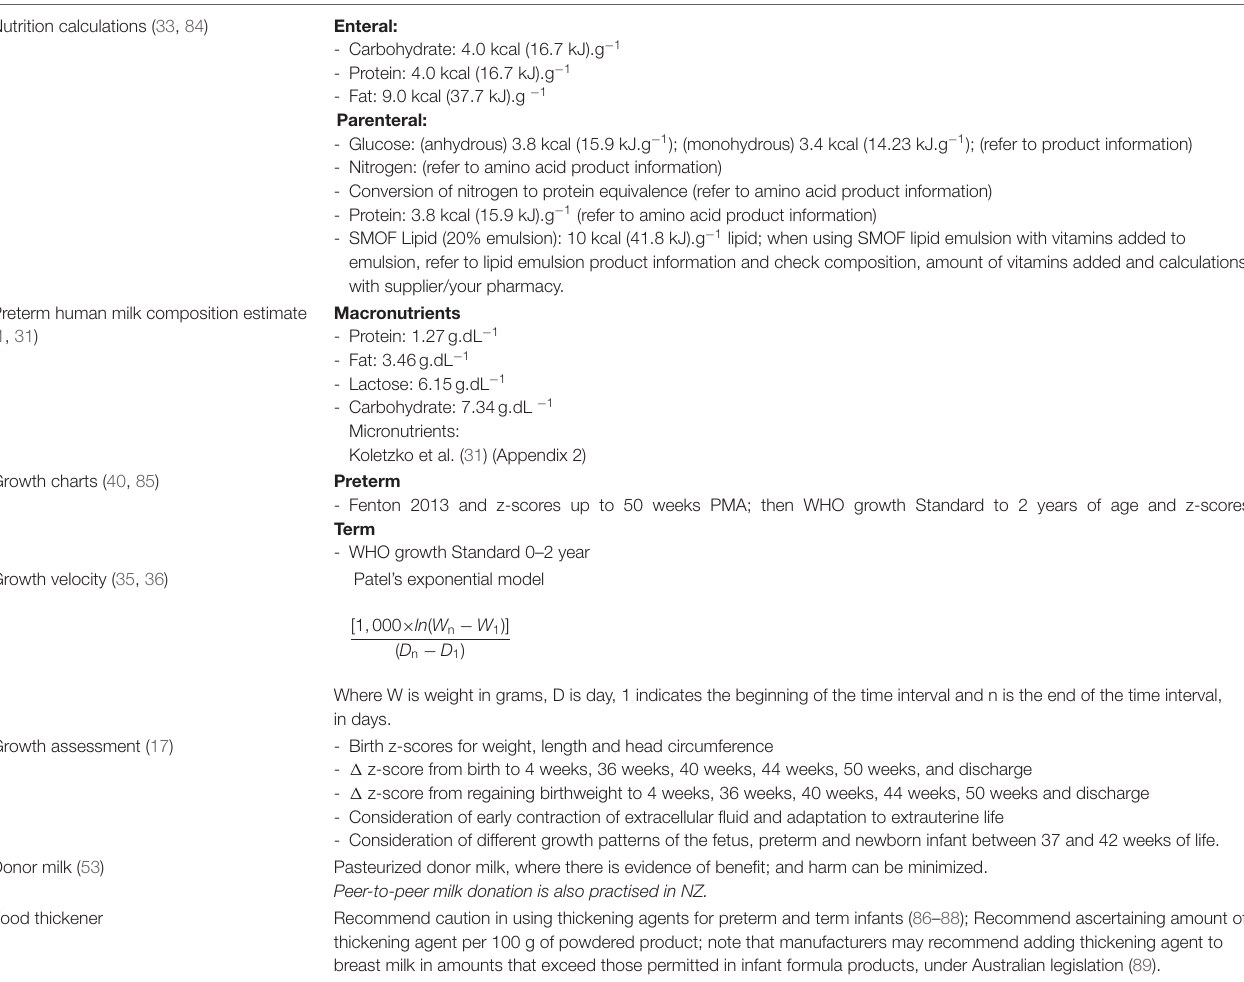
TABLE 5 | ANDiN consensus for nutrition practice, calculations, and reporting [adapted from (16)]. Nutrition calculations (33, 84)